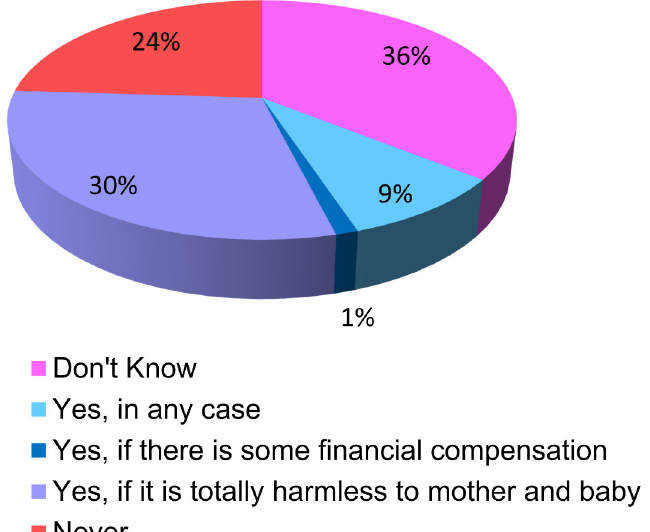
Fig 3. Willingness to bank cord blood for research (if given an option), keeping in mind the larger picture of future benefit to the